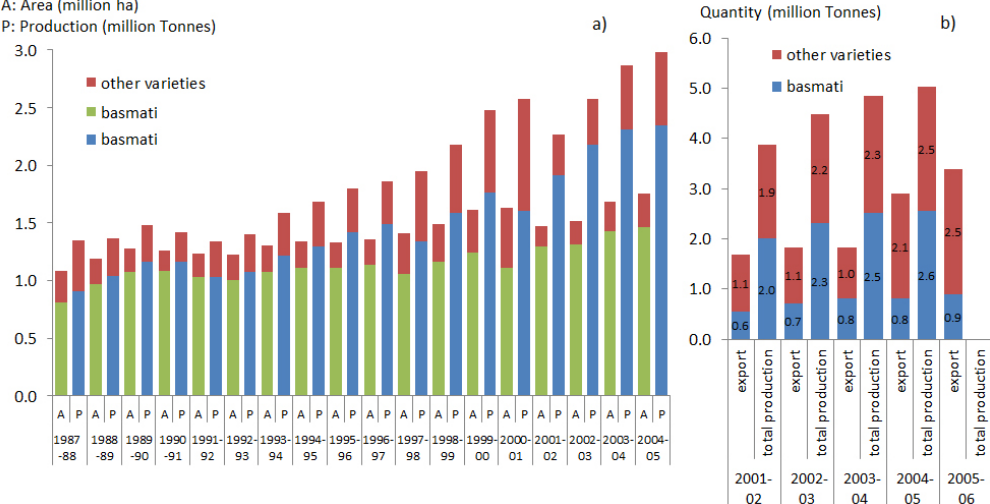
Fig. 8. (a) Area (millionha) and production (milliont) of rice (basmati and other varieties) in Pakistani Punjab from 1987–1988 to 2004– 2005. Data source: GOP (2005); (b) total production and export of rice (basmati and other varieties) for Pakistan from 2001–2002 to 2005–2006. Data source: GOP